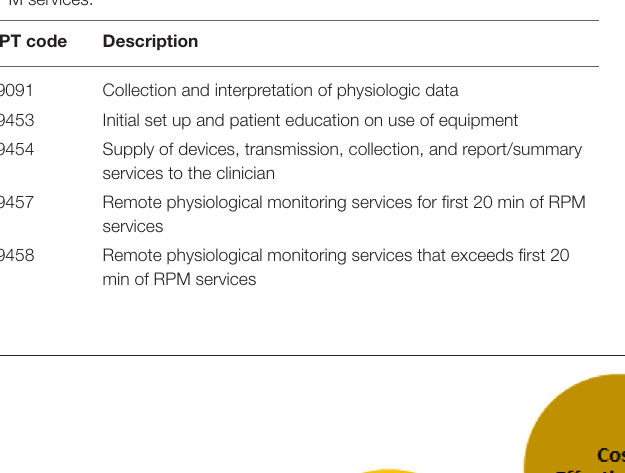
Frontiers in Communications and Networks |